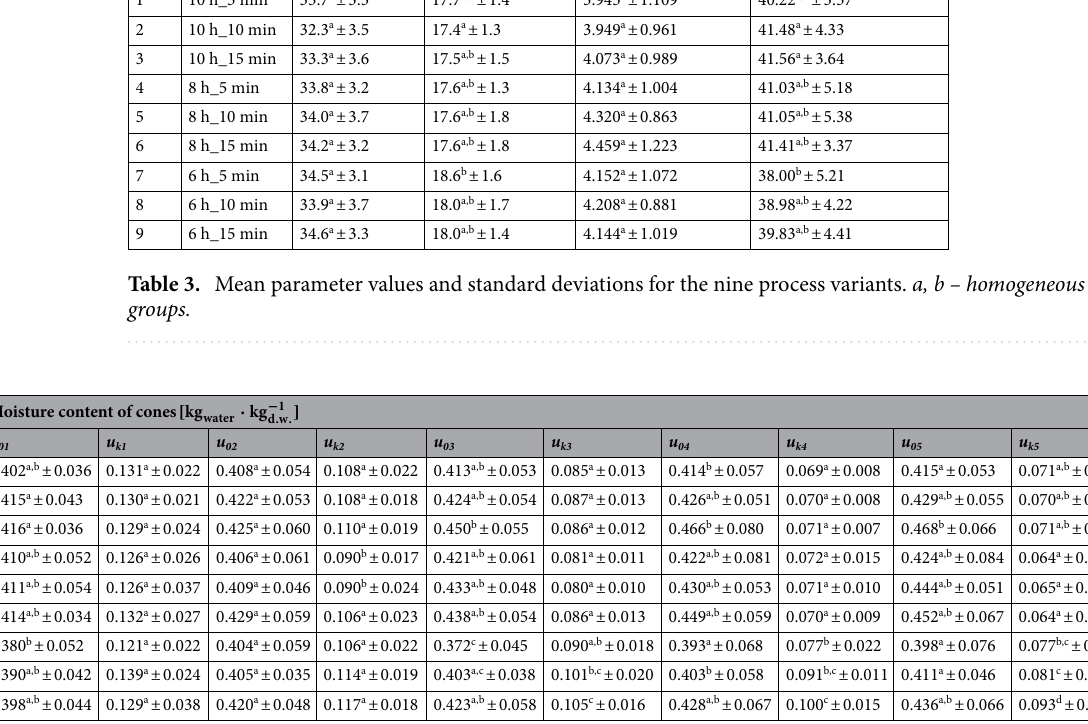
Table 4. Initial and final moisture content of cones used in each process variant. a, b, c, d – homogeneous groups.